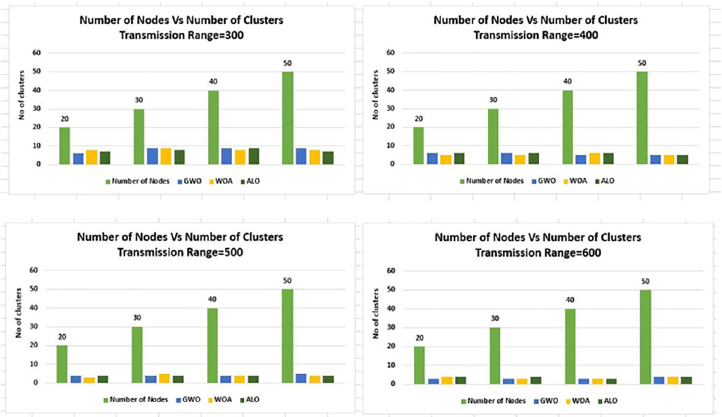
Fig 10. Node density versus number of clusters for transmission range 300m-600m & grid 1Km × 1Km.